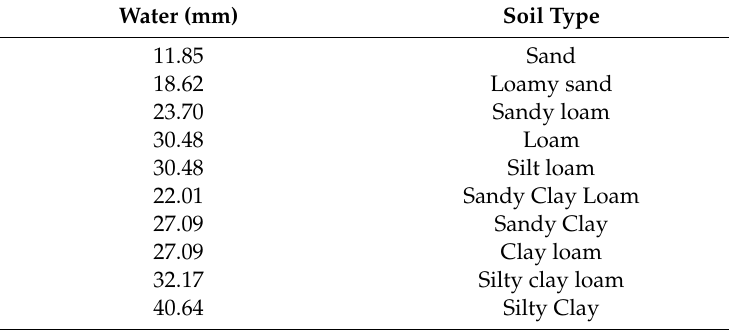
Figure A2. Soil textural triangle. Table A1. Soil field capacity quantities in the top 203.2 mm (8 inches) of soil used for analysis in the water balance model.